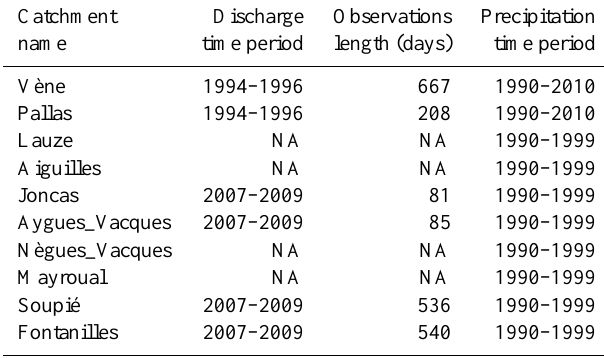
Table 1. Discharge and precipitation data available for each catchment. Catchment